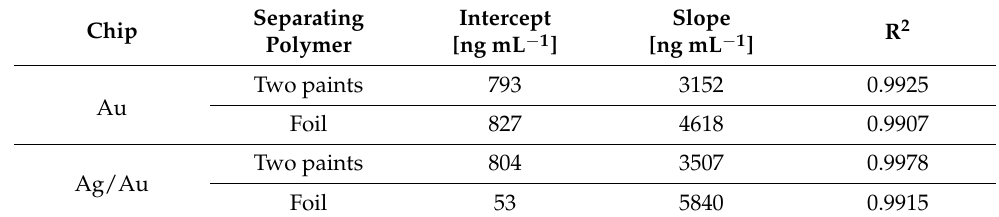
Table 2. Parameters of linear sections of calibration curves of Cath D determination.